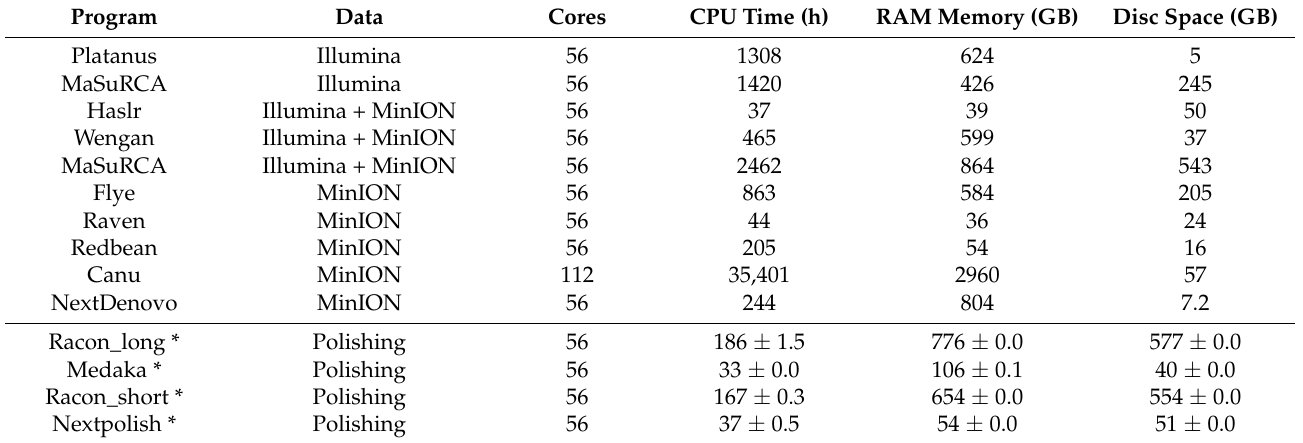
Table 5. Computational requirements for assemblers and assembly polishing